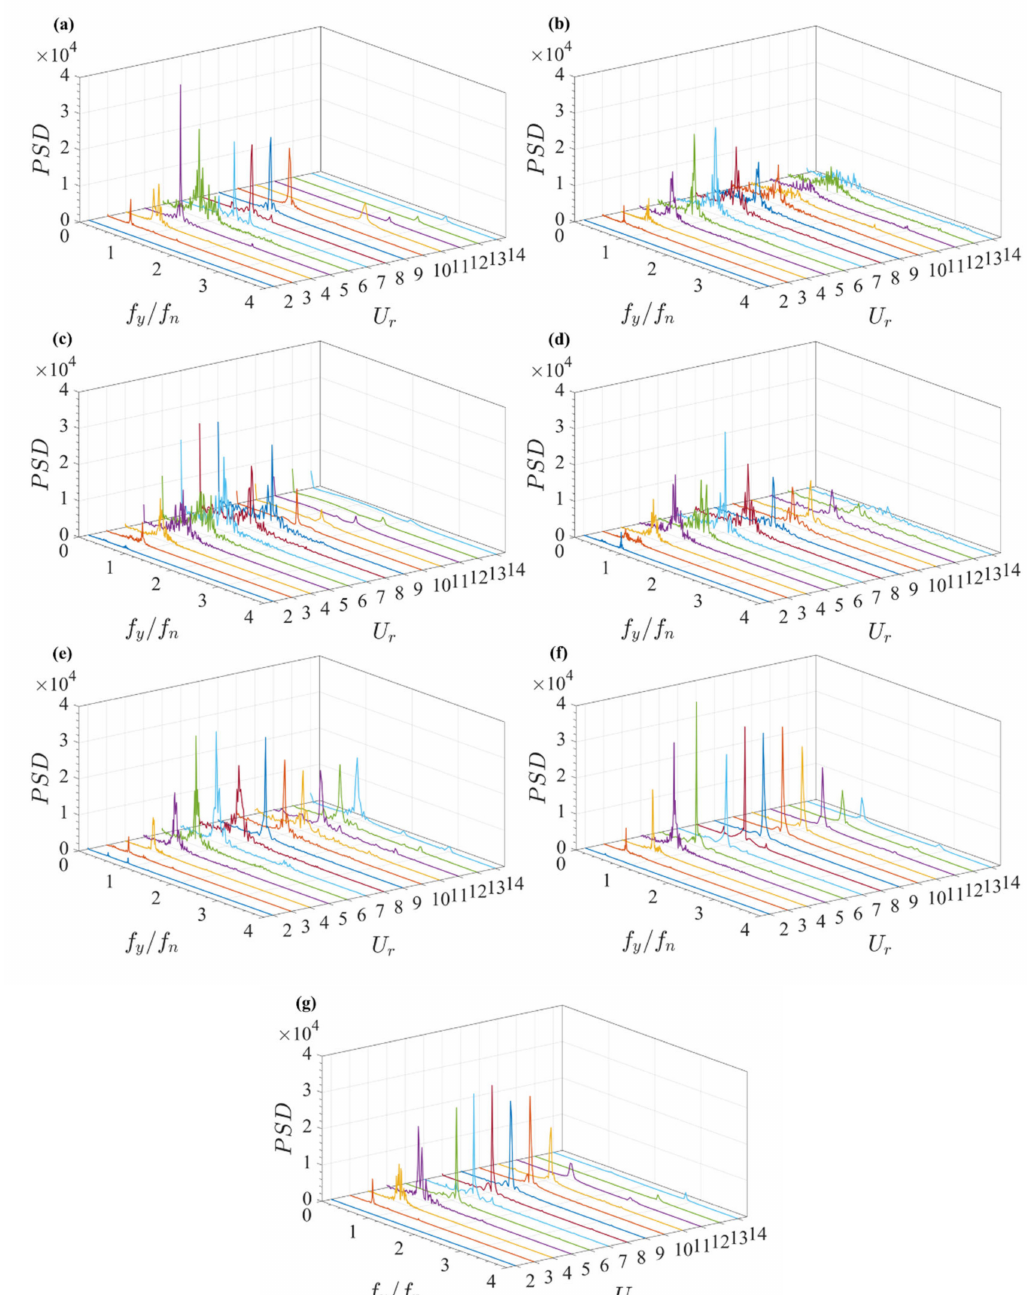
Figure 4. Normalized FFT amplitude spectra of the transverse displacement: ( a ) a single cylinder; ( b ) α = 0 ◦ , d/D = 0.3; ( c ) α = 90 ◦ , d/D = 0.3; ( d ) α = 180 ◦ , d/D = 0.3; ( e ) α = 0 ◦ , d/D = 0.2; ( f ) α = 0 ◦ , d/D = 0.1; ( g ) α = 0 ◦ , d/D =